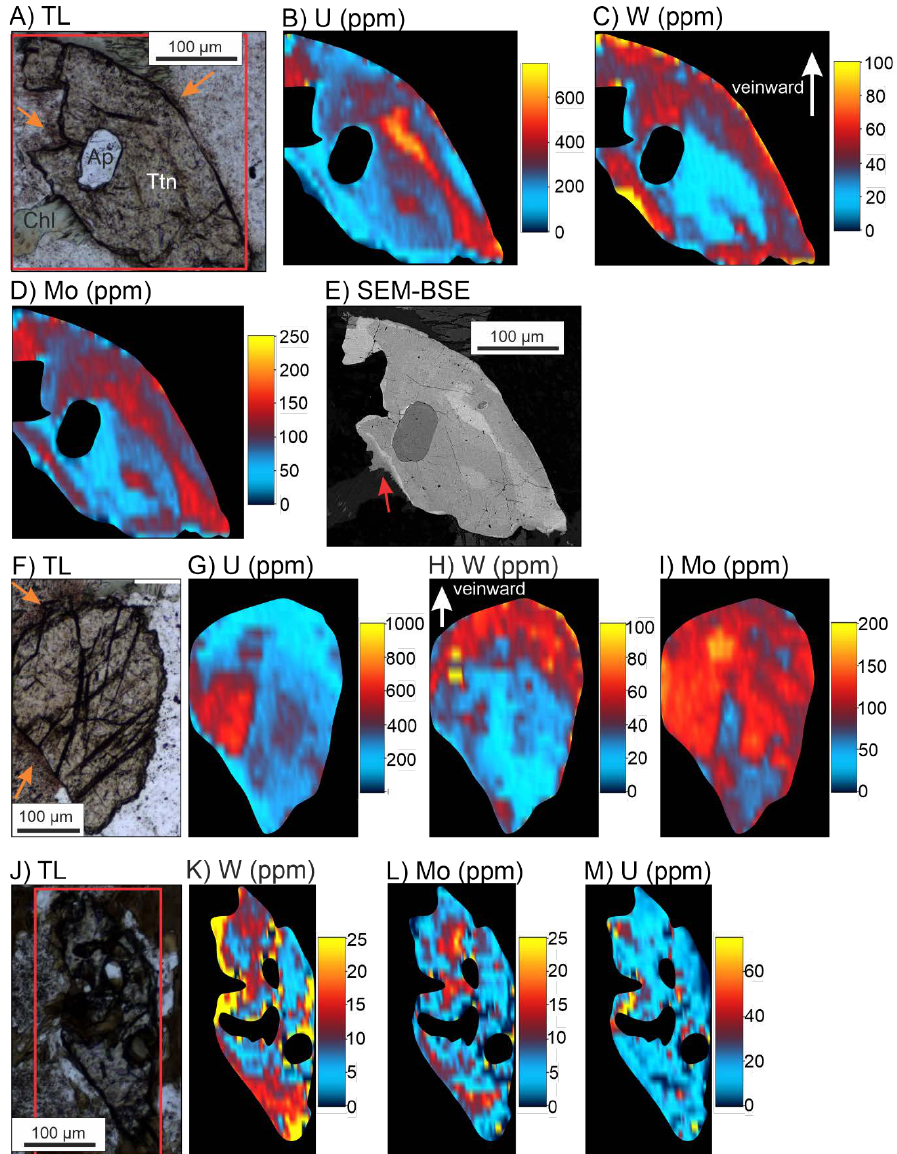
Figure 8. Petrographic images and LA ICP-MS maps of titanite showing visible textures and distribution of W, U, and Mo. Maps of magmatic titanite grains ( A – I ) demonstrate enrichment of W and Mo on the veinward side of the grain (top, indicated by white arrow). Elemental abundances are standardized to titanite and other minerals have been masked out in compositional maps. ( A ) Transmitted light image of magmatic titanite (Ttn) grain from diorite with apatite (Ap) inclusion and chlorite (Chl). Red box indicates area of LA ICP-MS mapping, and orange arrows indicate metamictization of surrounding minerals from U in the titanite (sample from drill core SB0806 at 69 m), ( B ) laser ablation map of U, ( C ) laser ablation map of W, ( D ) laser ablation map of Mo. ( E ) SEM-BSE image of grain in A showing coupled dissolution reprecipitation of titanite (red arrow). ( F ) Transmitted light image of magmatic titanite grain from diorite, and orange arrows indicate metamictization of surrounding minerals from U in the titanite (sample from drill core SB0806 at 69 m), ( G ) laser ablation map of U, ( H ) laser ablation map of W, ( I ) laser ablation map of Mo. ( J ) Transmitted light image of metamorphic titanite grain from mafic tu ff . Red box indicates area of LA ICP-MS mapping (sample from drill core SB0845 at 57.3 m), ( K ) laser ablation map of W, ( L ) laser ablation map of Mo, ( M ) laser ablation map of